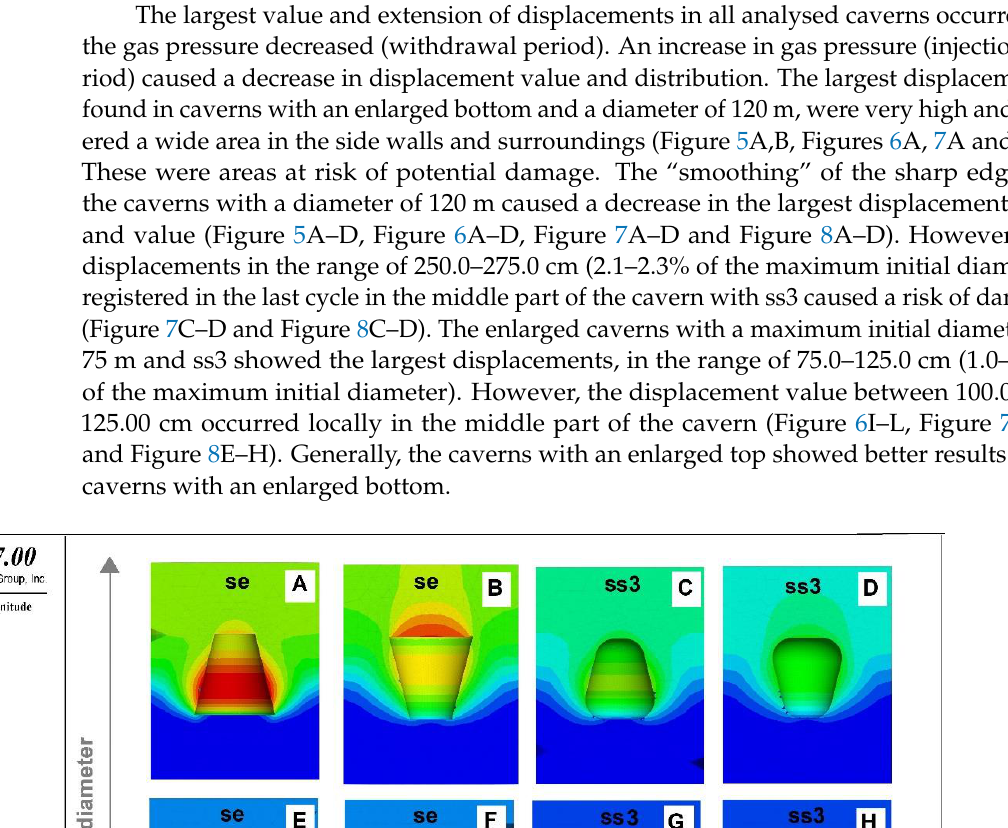
Figure 7. The displacement value and distribution in simulated caverns; the last withdrawal period: ( A – D ) caverns with a maximum initial diameter of 120 m, ( E – H ) caverns with a maximum initial diameter of 75 m.